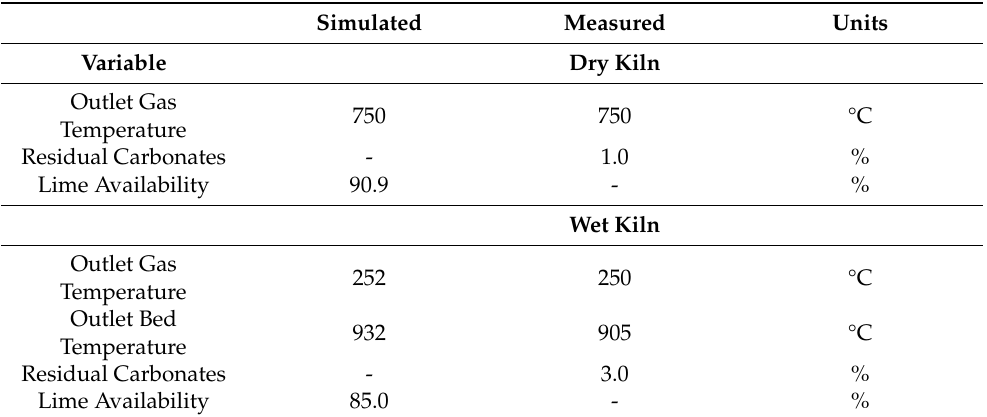
Table 3. Dry and wet kiln steady-state simulated vs measured values.